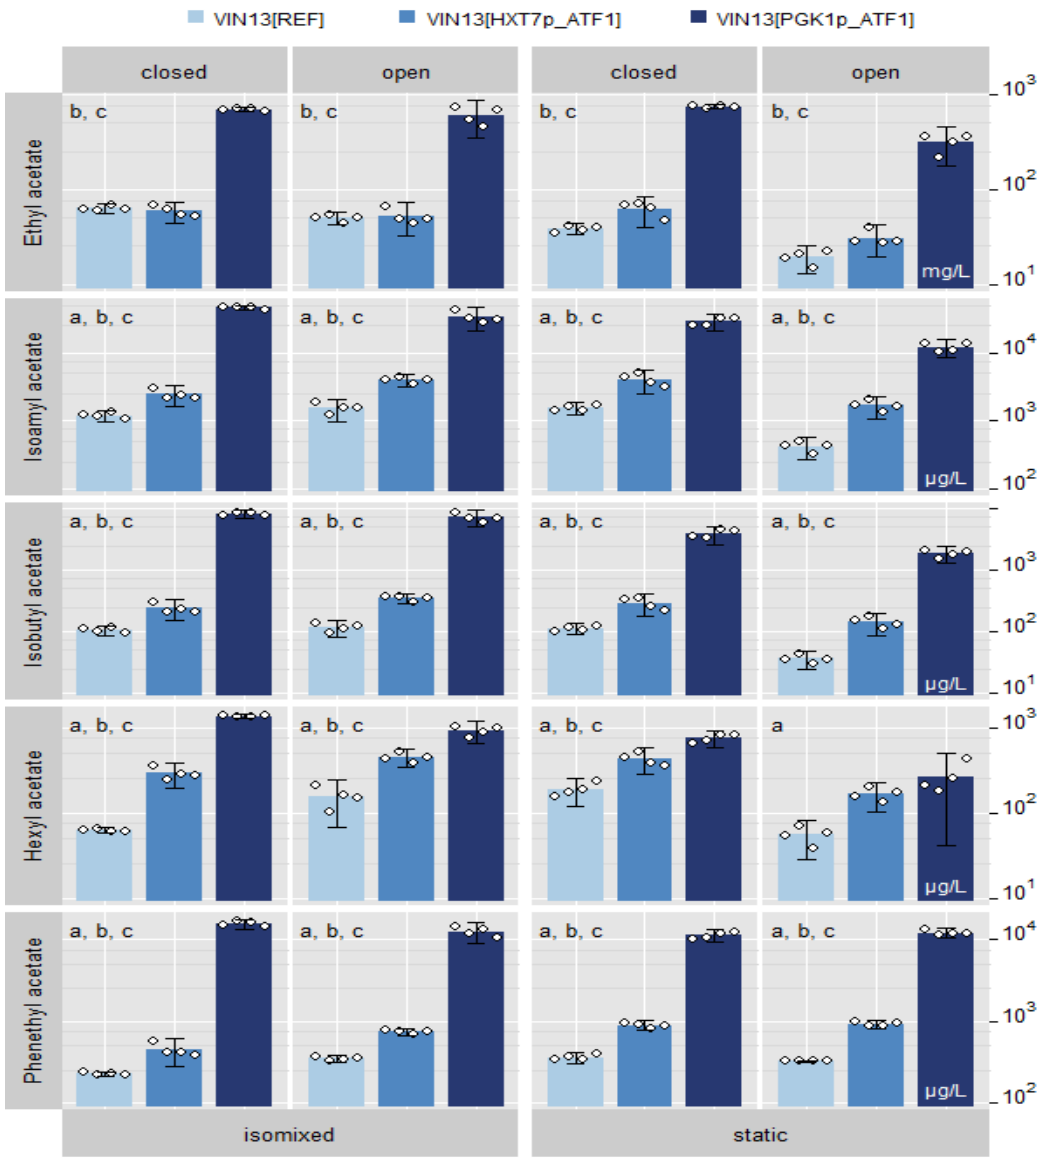
Figure 5. Effect of HXT7 promoter on the expression of ATF1 in a wine fermentation. Acetate ester levels of the final Müller-Thurgau wines fermented with the ATF1 -overexpressing VIN13 strains produced from the is omixed and static fermentations. Values are in μg/L , except for ethyl acetate, which are in mg/L. The error bar represents 2 times standard deviation of a quadruplicate. Significance was assessed by linear contrasts with family-wise error rate of 0.05 for each acetate ester; letters a, b and c identify significant ( p < 0.05) pairwise differences a: between VIN13[REF] and VIN13[HXT7p_ATF1], b: between VIN13[REF] and VIN13[PGK1p_ATF1], c: between VIN13[HXT7p_ATF1] and VIN13[HXT7p_ATF1].